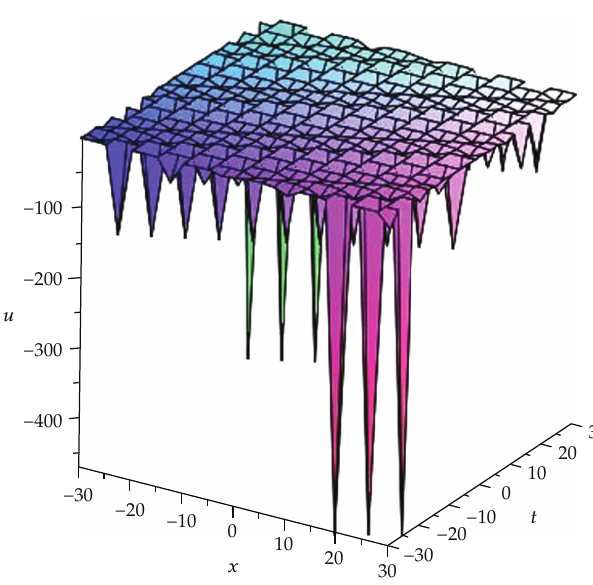
Figure 4: The solution u 1 of GSWW equation with k (cid:7) 0 . 3, c (cid:7) 2, α (cid:7) 3, β (cid:7)